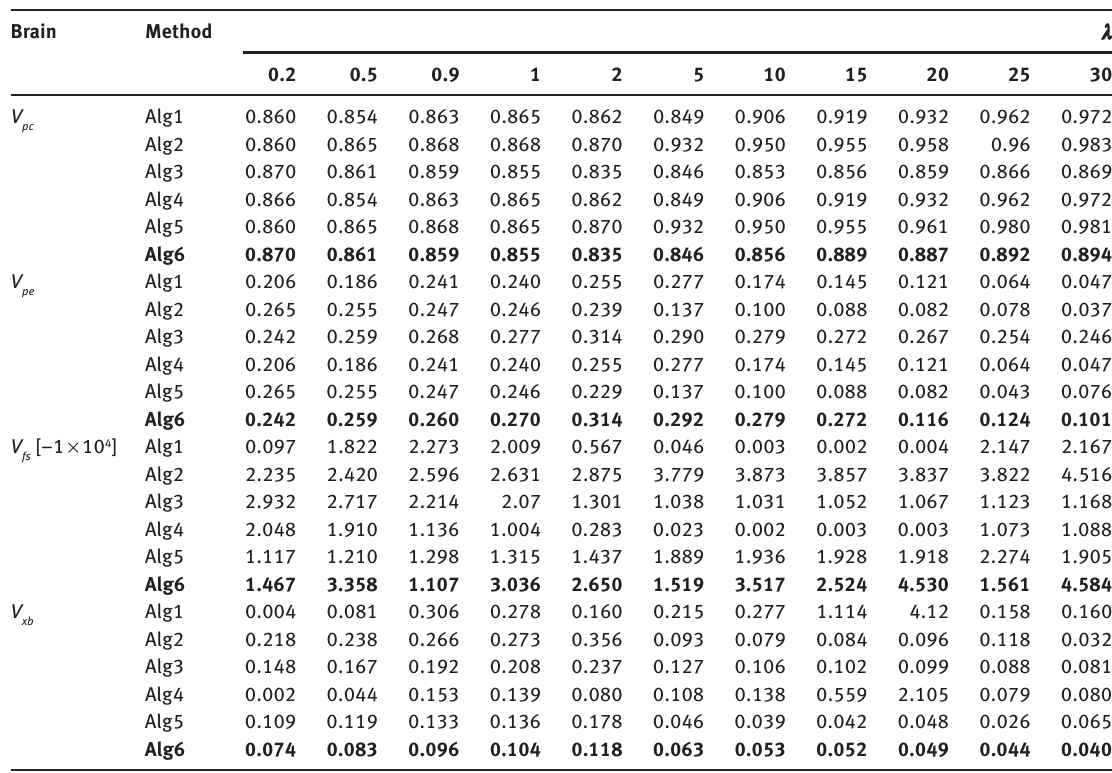
Table 4: Performance Comparison for Brain